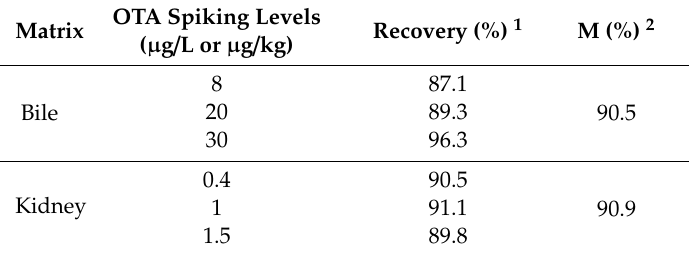
Table 3. Recovery data of the method for analysis of OTA in samples of bile and kidney spiked at three concentration levels. Matrix